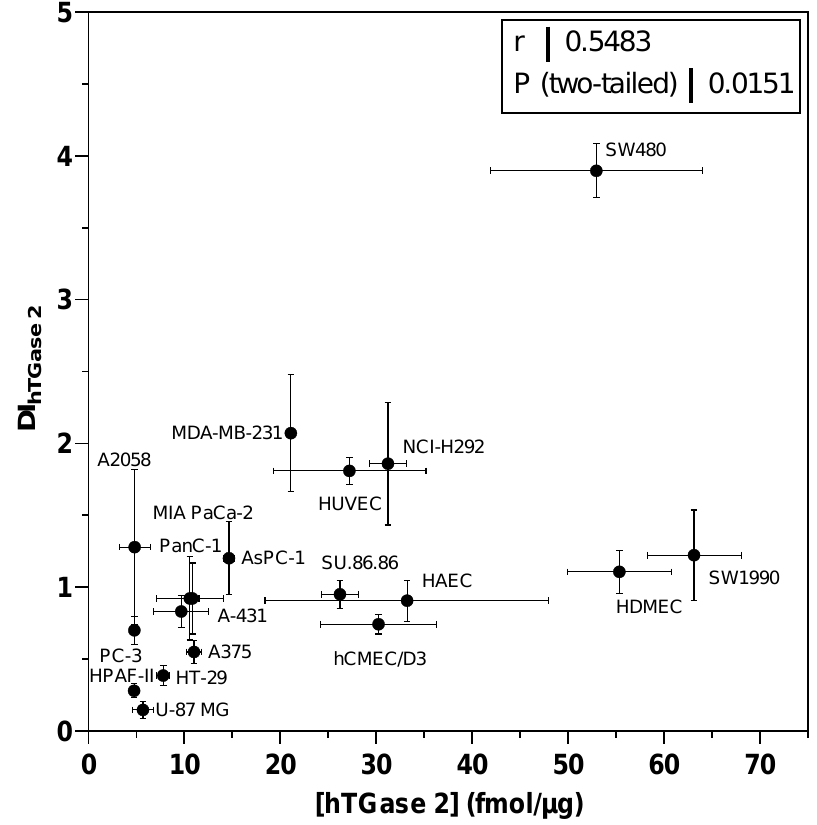
Figure 8. Correlation of relative expression values for hTGase 2 obtained by Western blot analysis with concentrations of active hTGase 2 obtained by the FA-based assay. Data for correlation are taken from Figure 4 (FA-based assay) and Figure 7 (Western blot). Only those cell lines showing hTGase 2 activity above the detection limit (Figure 4A) were considered for correlation.